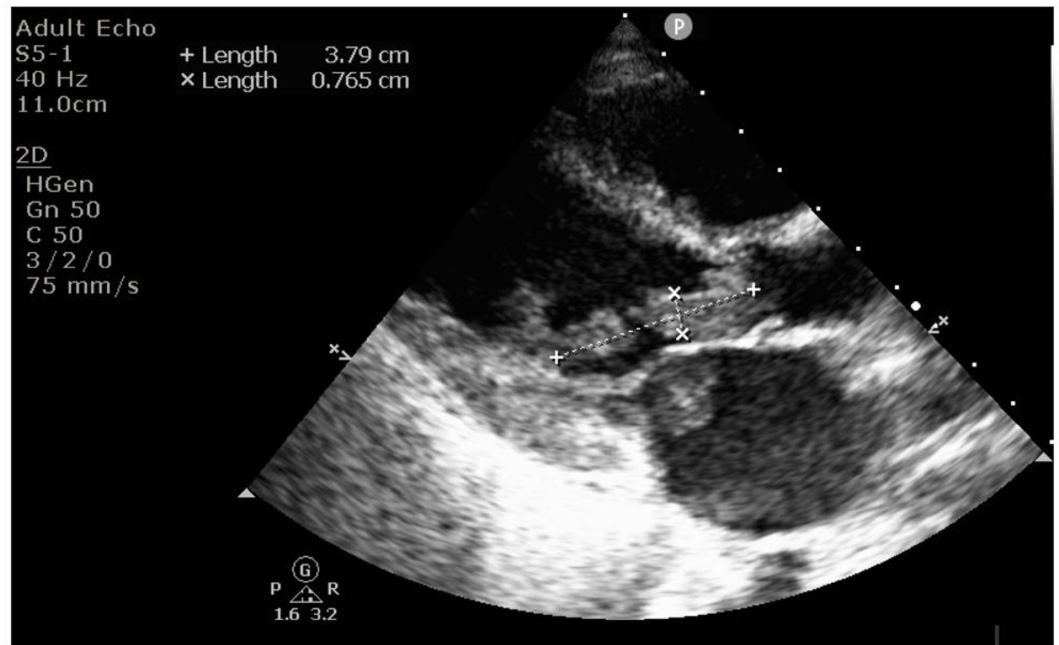
Figure 5. Long vegetation attached to the mitral valve below the valve, directed towards the left ventricle ejection tract, measuring 3.8 × 0.7 cm.